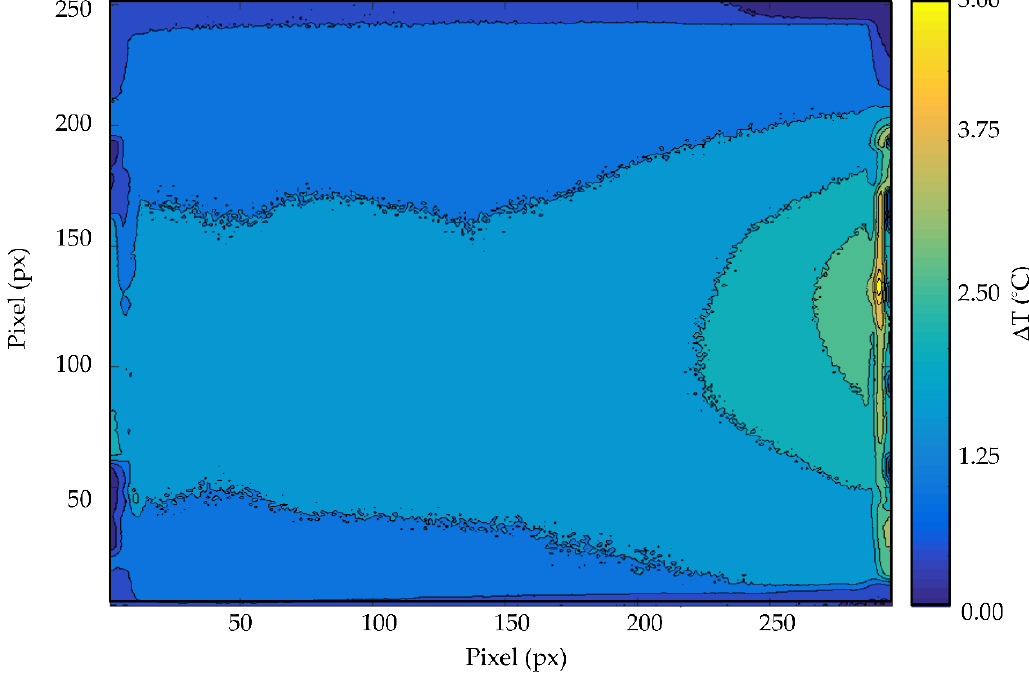
Figure 8. Illustration of distribution of temperature increases observed in the investigated prototype sample after 80,000 cycles of charging / discharging at a current density of 5 A / g and polarizing voltage 1.5 V; significant changes of C and R ESR were recorded.